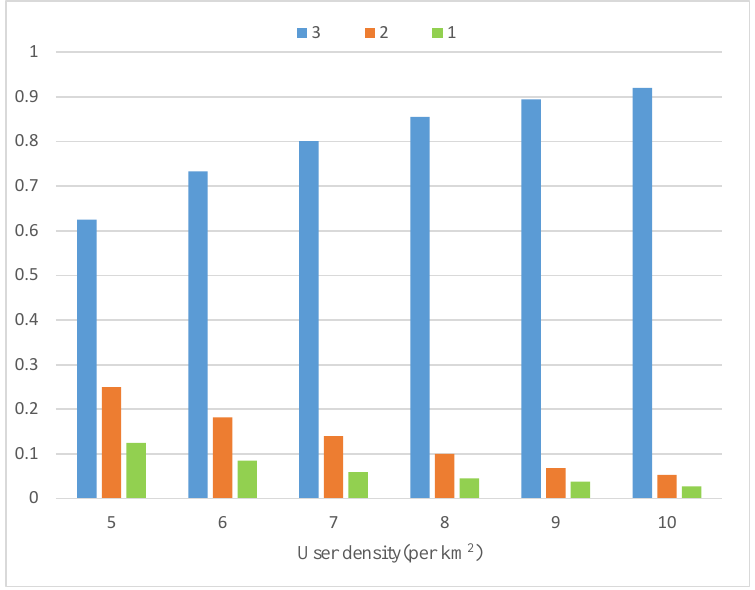
Figure 7. Matching distribution under different user density.